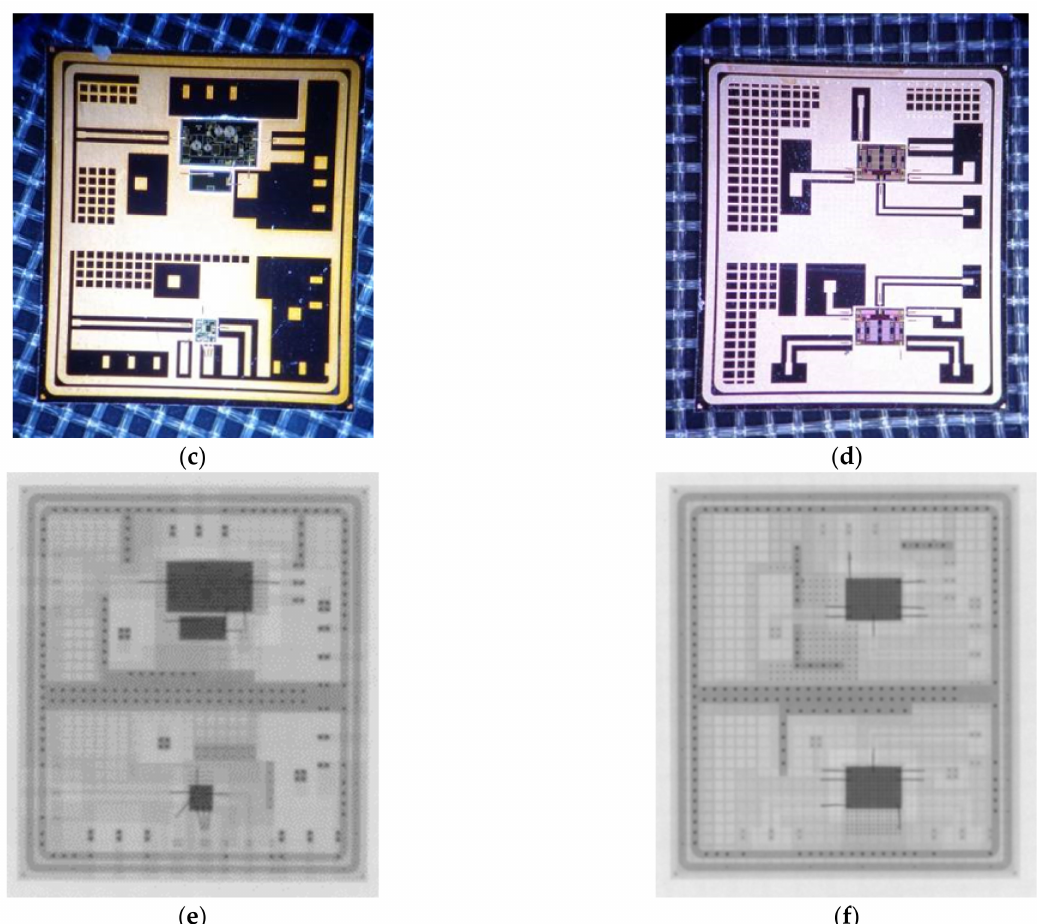
Figure 18. 4-layer stacked RF front-end module: ( a ) Layout of the bottom two layers, ( b ) layout of the top two layers, ( c ) photo of the bottom unit, ( d ) photo of the top unit, ( e ) X-ray of the bottom unit, ( f ) X-ray of the top unit.